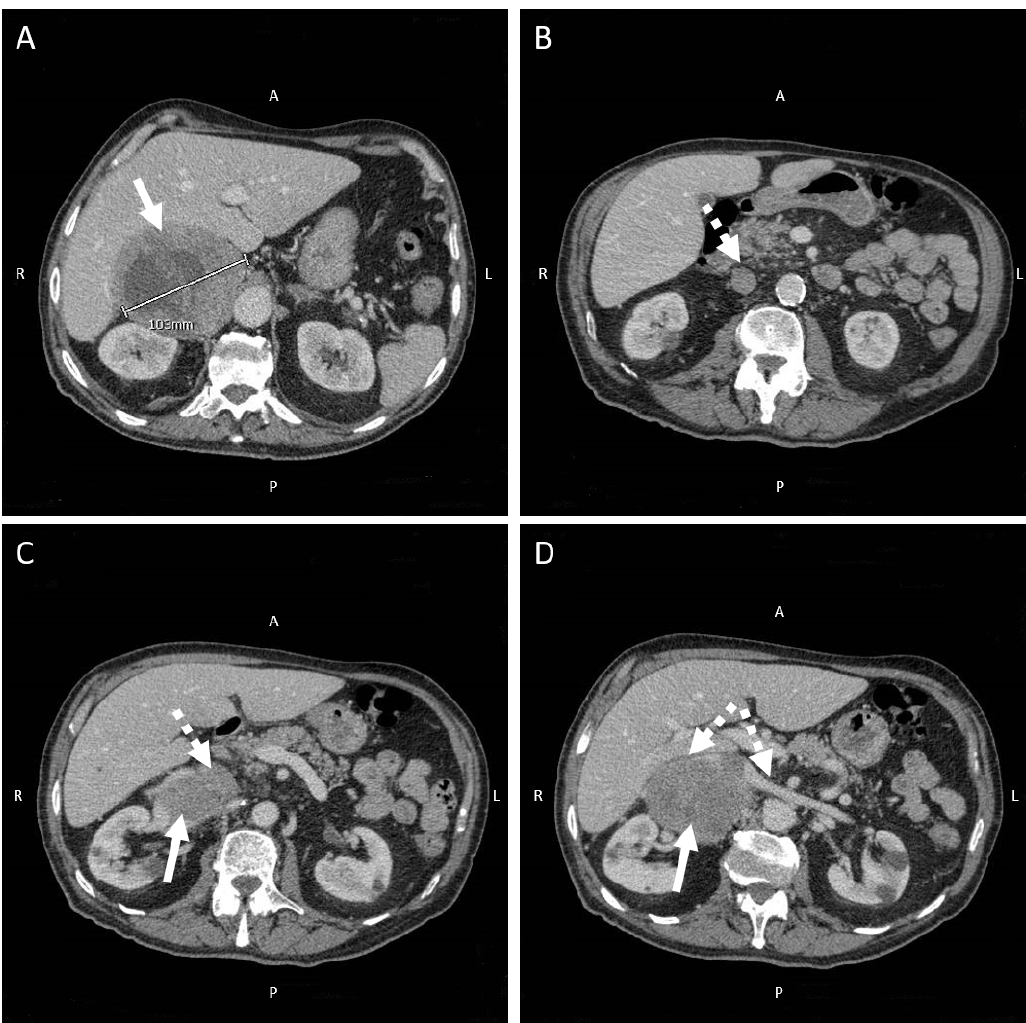
Figure 3. ( A – D ). Computed tomography of the abdomen in a patient with suspected